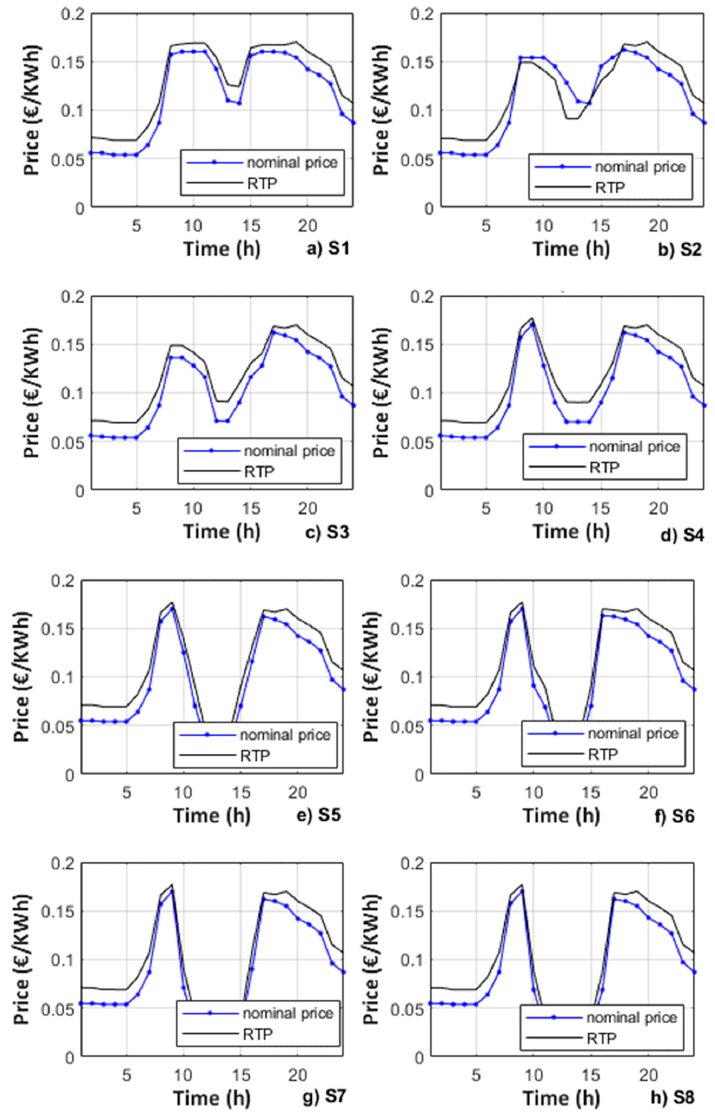
Figure 4. Nominal price and RTP corresponding to day 2 January 2019 for: ( a ) S1, ( b ) S2, ( c ) S3, ( d ) S4, ( e ) S5, ( f ) S6, ( g ) S7, and ( h ) S8. (source: Authors).